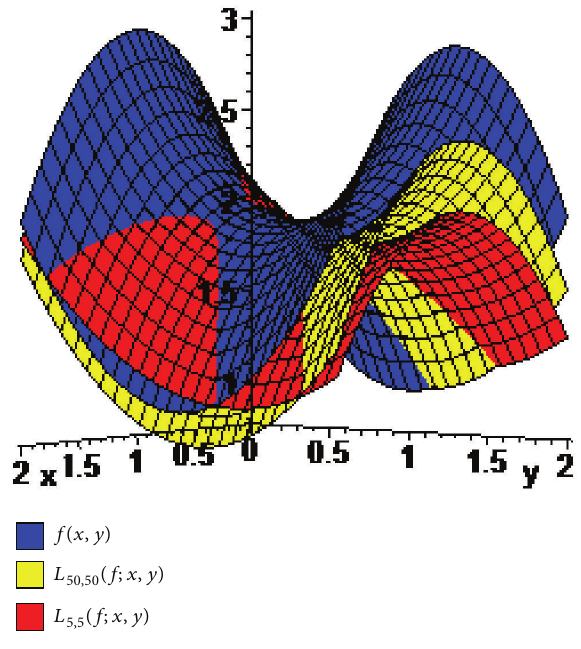
Figure 1: The convergence of 𝐿 𝑛,𝑚 (𝑓;𝑥, 𝑦) to 𝑓(𝑥,𝑦) for 𝑛, 𝑚 = 5 and 𝑛,𝑚 = 50